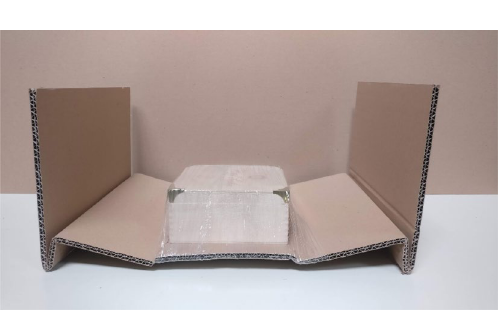
Fig. 3 Insufficient panel